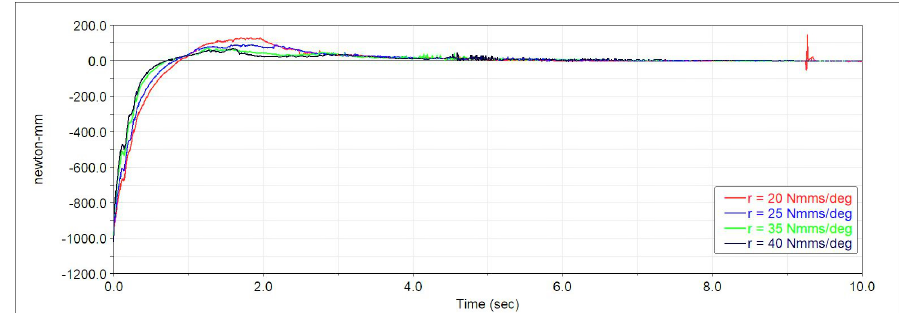
Figure 13. Spring-damper system torque of the first cell as a function of the simulation time and when the damping coefficient of the damper varies from 20 to 40 N · mm ·